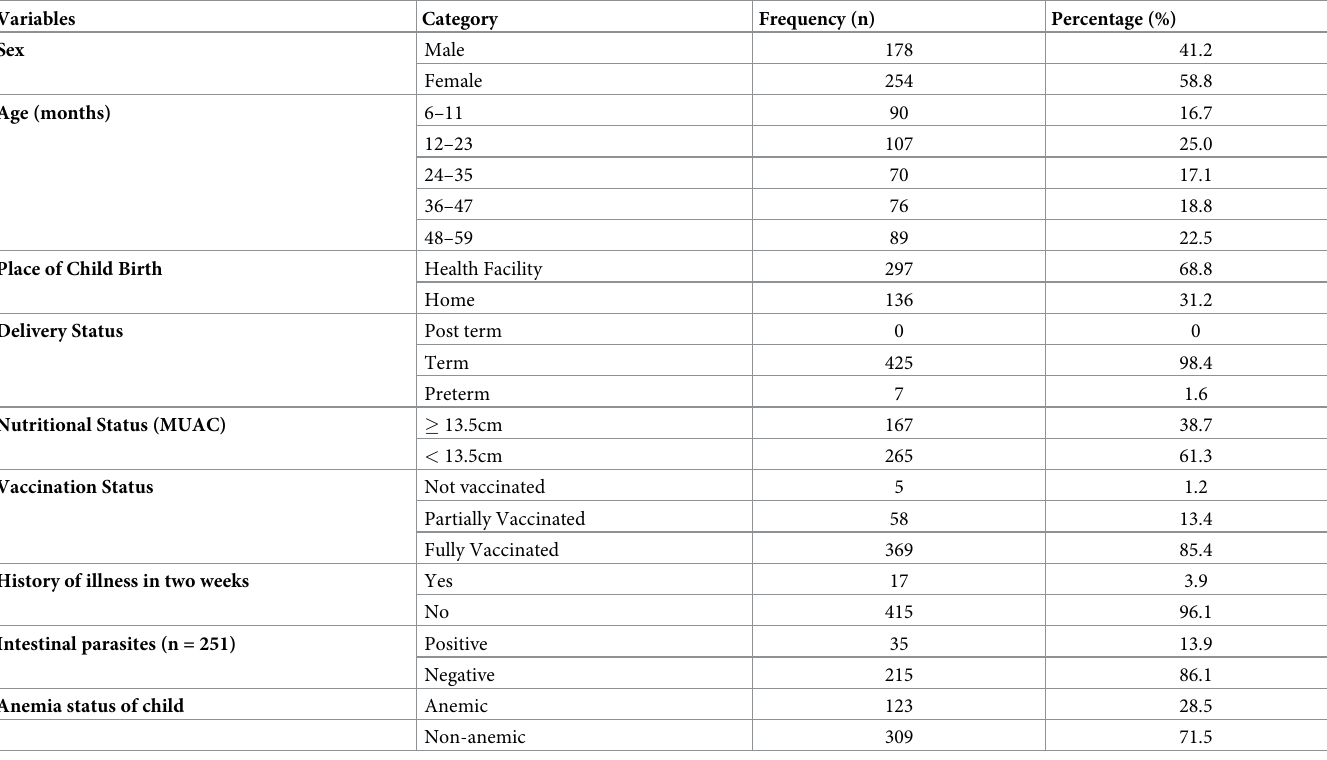
Table 1. Socio-demographic and health related characteristics of children aged 6 to 59 months in the Menz Gera Midir district Northeast Ethiopia in 2021, (N = 432).